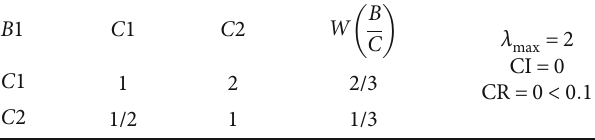
Table 3: Judgment matrix B 1 ~ Ci ð i = 1 ~ 2 Þ .